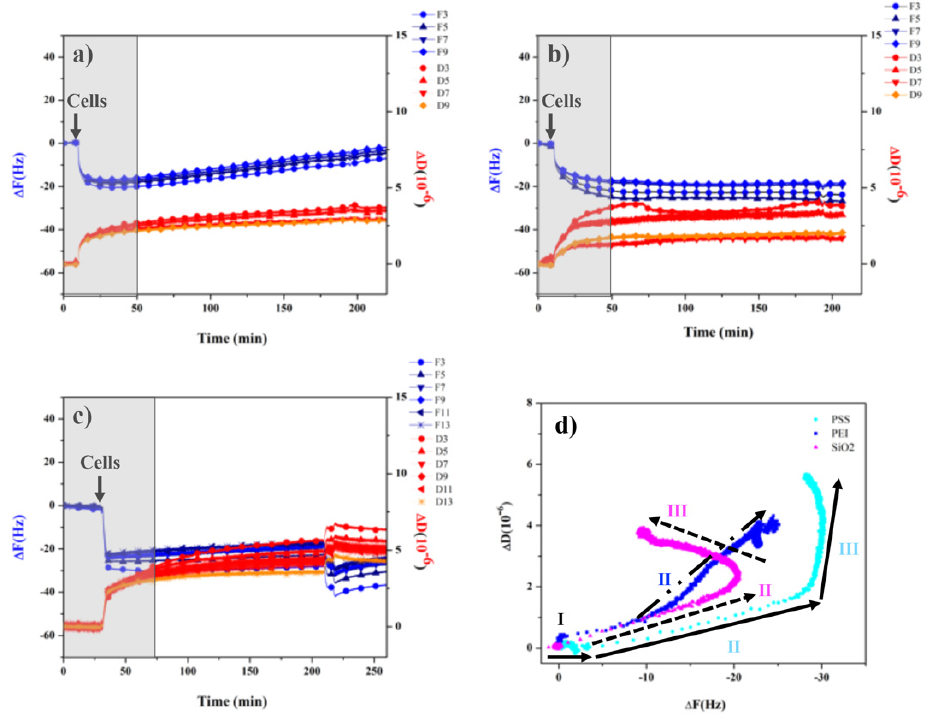
Figure 7. QCM-D frequency and dissipation versus time curves for cells added to ( a ) SiO 2 , ( b ) PEI, and ( c ) PSS. ( d ) Plot of ∆ D as a function of ∆ F of cells on SiO 2 (magenta), PEI (blue), and PSS (cyan).